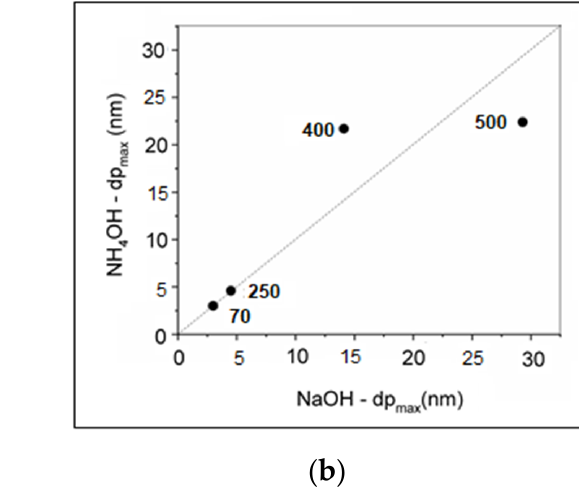
Figure 10. Relation between ( a ) BET specific surface areas and ( b ) pore size maxima of Fe 2 O 3 nanoparticles prepared using the precipitators NaOH and NH 4 OH and calcined at different temperatures. The reactivity of oxygen in the NPs precipitates Fe 2 O 3 _Na-70, Fe 2 O 3 _NH-70 and NPs